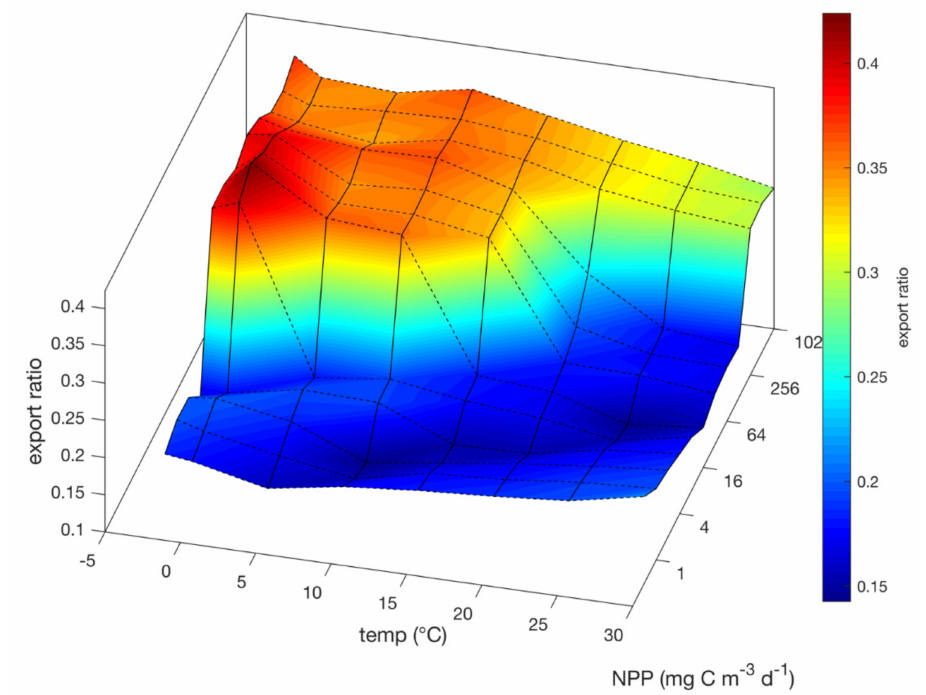
Figure 2. Map of ef ratios that produce a food web with maximum resiliency as a function of temperature and